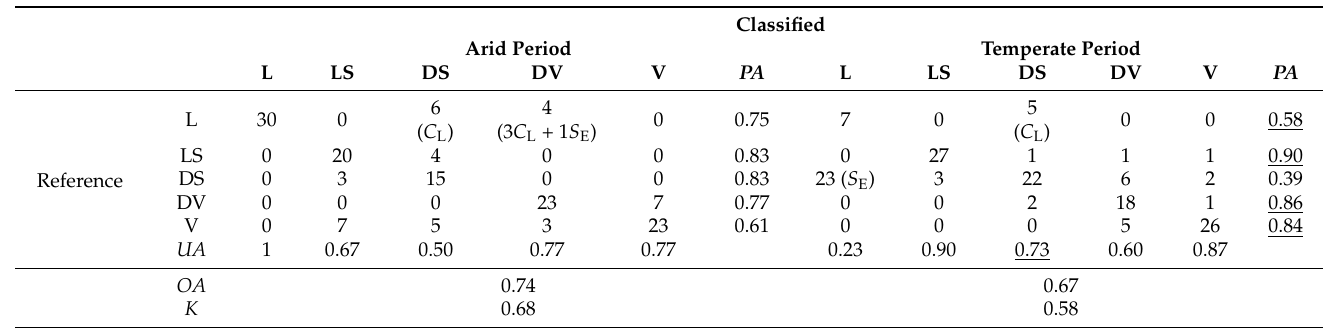
Table 4. Error matrix of the NN classification. When the achieved accuracy is higher than that achieved by the RF classifier, its value is underlined.